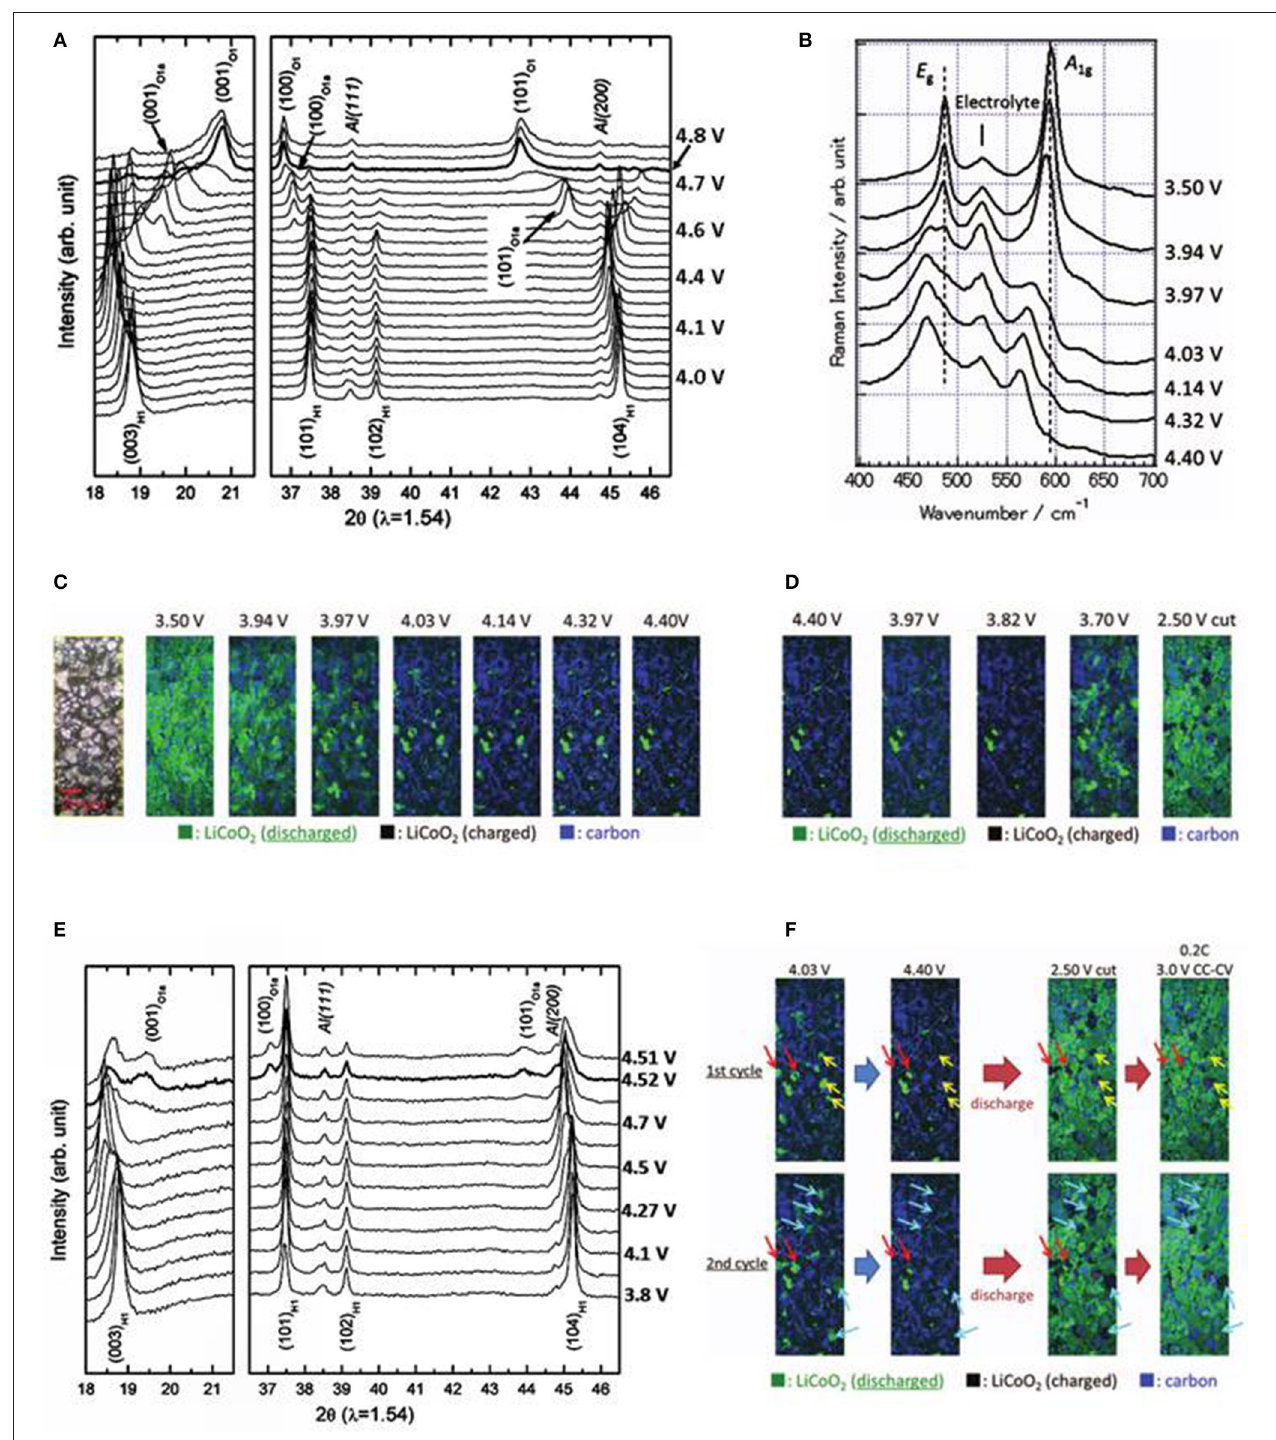
FIGURE 2 | Operando XRD and Raman measurements on LiCoO 2 electrodes; (A) XRD spectra during the first charge to 4.8V at C/4.5, demonstrating a complete phase transformation from H1 to O1. (Chung et al., 2006); (B) Raman spectra from first charge, 3.5–4.4V at C/2.5 rate (Nishi et al., 2013); (C) In situ Raman images at various potentials during first charge to 4.4V at C/2.5 rate with corresponding optical graph at the left (Nishi et al., 2013); (D) In situ Raman images at various potential during first discharge, 4.4–2.5V at 1C rate (Nishi et al., 2013); (E) XRD spectra from 5th charge to 4.8V at C/4.5, showing an incomplete phase transition between H1 and O1. (Chung et al., 2006); (F) In situ Raman images collected from 1st and 2nd cycles; after galvanostatic discharge to 2.5V at 1C, the cell voltage was relaxed from 2.5 to 3.7V, the cell was then discharged to 3V at C/5 followed by holding at 3V for 3h which reduced the delithiated particles (Nishi et al.,